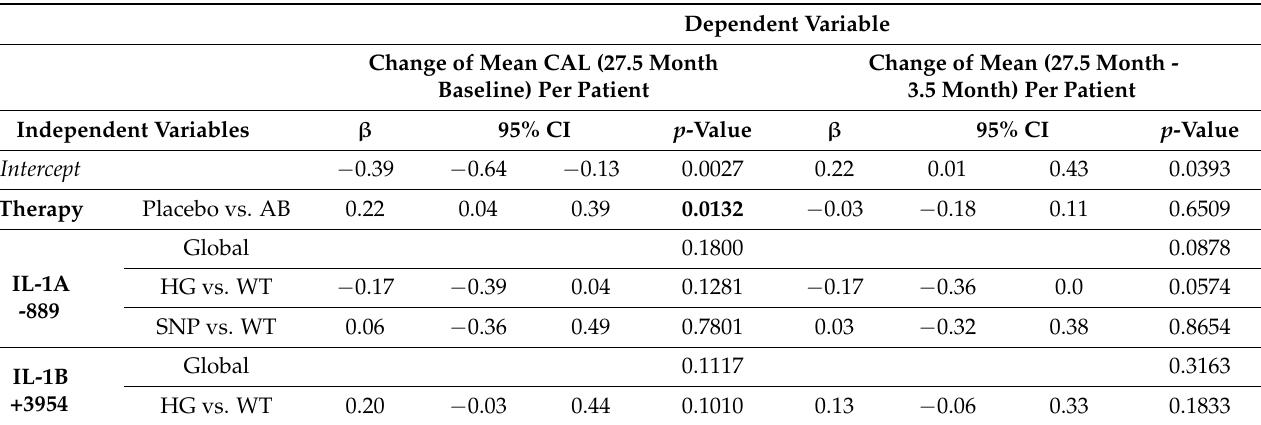
Table 6. Multivariable linear model estimates for the change of mean CAL from 27.5 months versus baseline and from 27.5 months versus 3.5